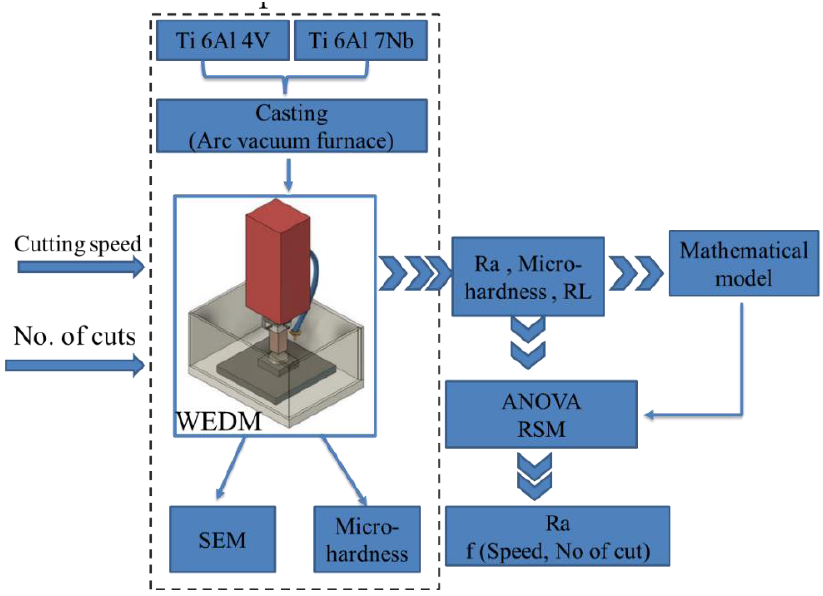
Figure 2. Experimental procedures flow chart.